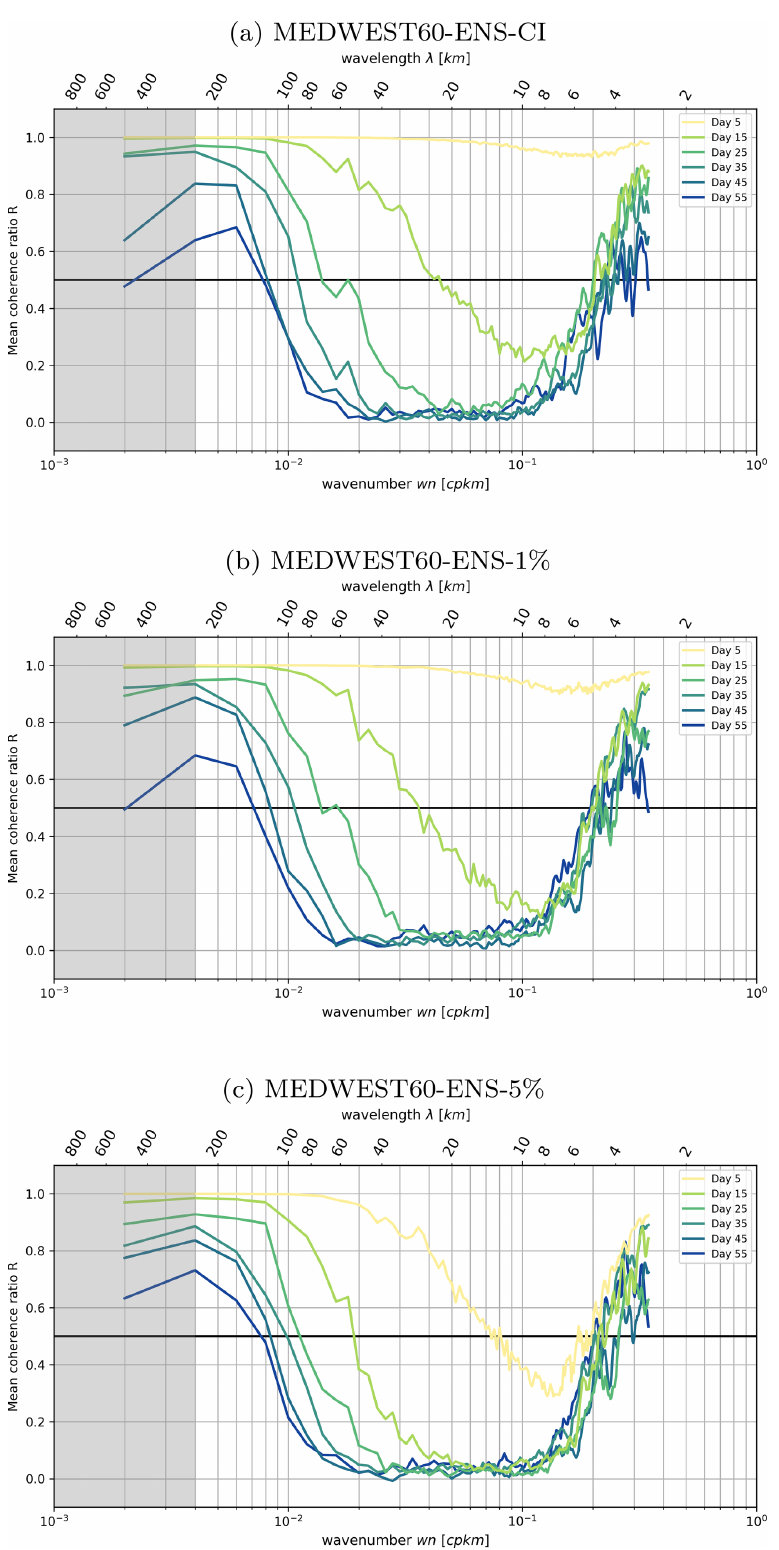
Figure 18. Mean coherence ratio R (see text for definition) from experiments ENS-CI, ENS-1% and ENS-5%. The ratio is computed at different time lags: time increasing from yellow to blue colors. The gray shading indicates where the spatial scales are not fully resolved within the considered region (scales larger than L/ 2 ∼